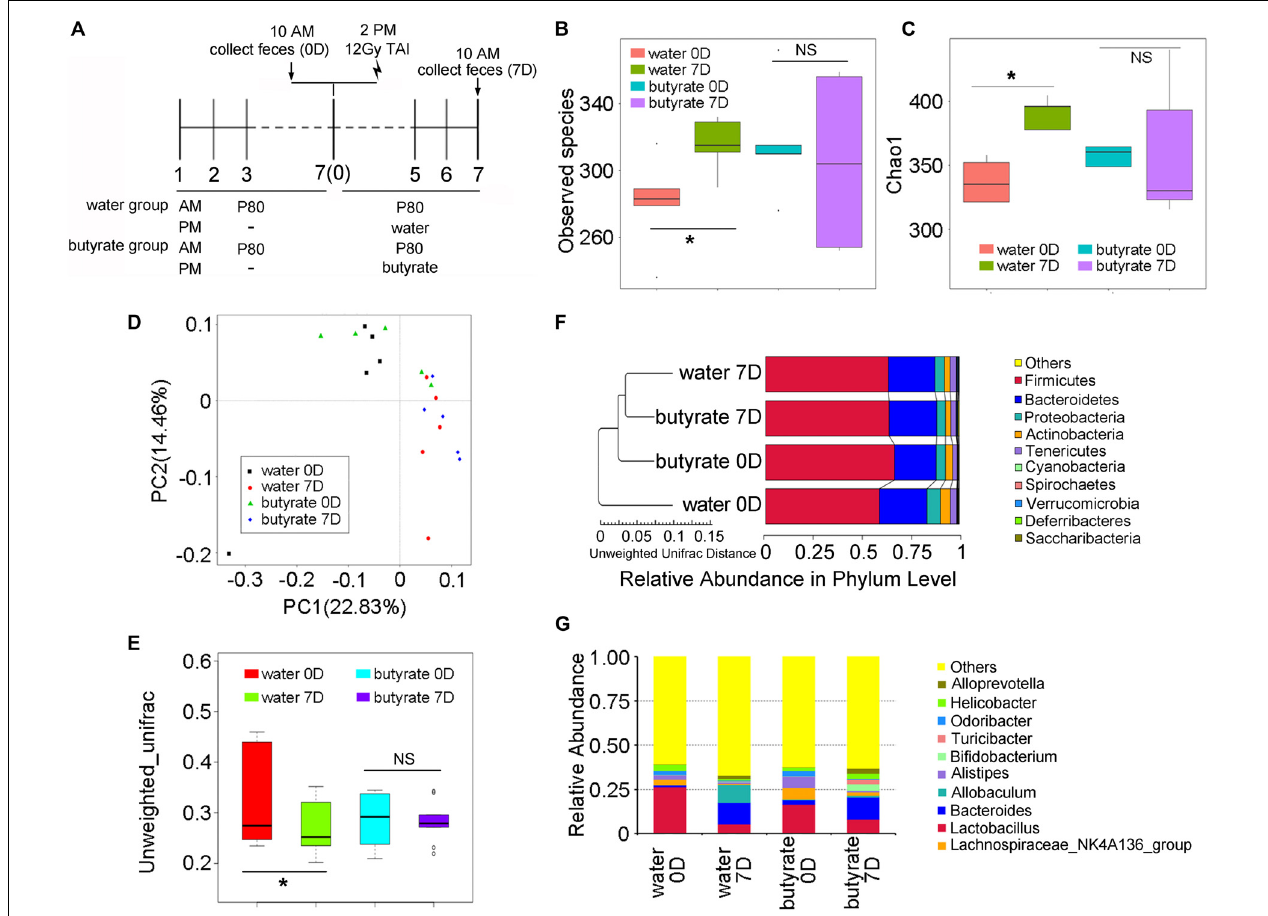
FIGURE 7 | Butyrate alters the fecal microbiota. (A) Experimental design. “Water” group is short for “TAI+P80+water” group, “butyrate” group is short for “TAI+P80+butyrate” group. (B,C) The observed species number (B) and Chao 1 index (C) of intestinal bacteria of mice were examined by 16S rRNA sequencing. Statistically significant differences are indicated: non significance (NS), * p < 0.05; TukeyHSD, n = 5 per group. (D,E) The PCA (D) and β diversity (E) of intestinal bacteria in irradiated mice were examined by 16S rRNA sequencing. Statistically significant differences are indicated: non significance (NS), * p < 0.05; TukeyHSD, n = 5 per group. (F) The relative abundance of intestinal bacteria at the phylum level of irradiated mice was assessed using 16S rRNA sequencing. (G) The relative abundance of enteric bacteria at the genus level of irradiated mice was assessed using 16S rRNA